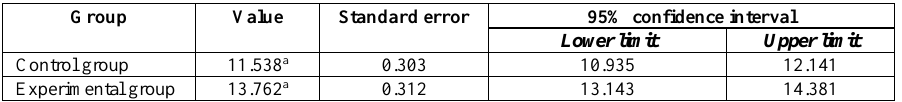
Table 2. Average Student Scores for the Post-Test Group